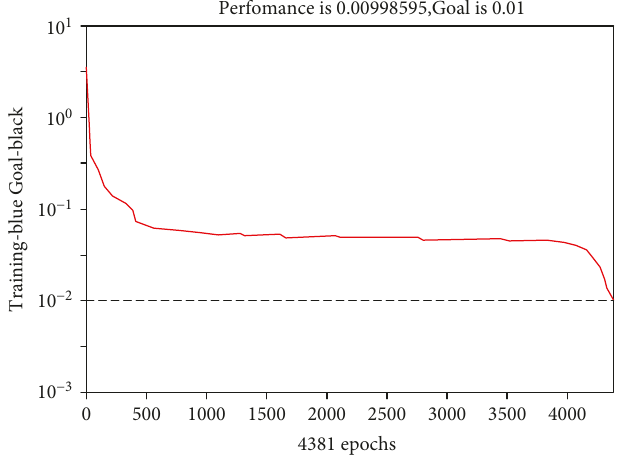
Figure 10: Momentum gradient training results.